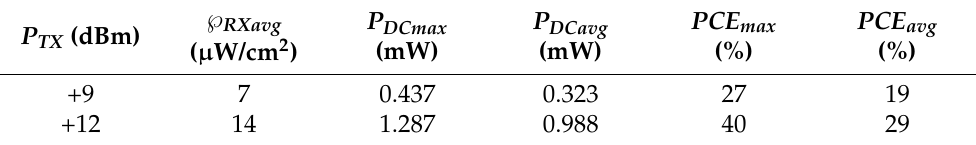
Table 6. 2 × 2 Rectenna Array On-body Measurements (2.40–2.48 GHz Band).